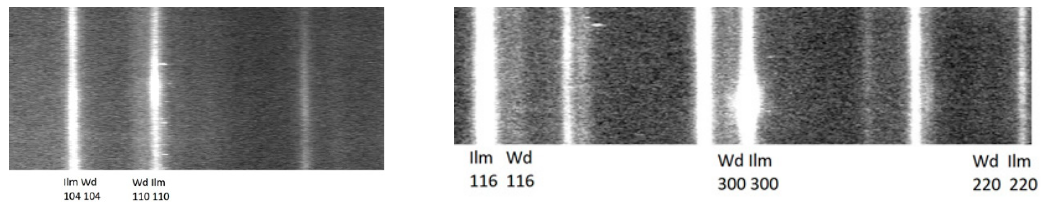
Figure 2. Diffractograms of ilmenite-wangdaodeite aggregates from Ries xenolith ZLN114c from the low angle and high angle range (left and right panel, respectively). Due to the noticeably different c/a ration, reflections of wangdaodeite occur at lower Bragg angles for the zone hk0 and at higher angles for hkl. Only fringes that are noticed as distinct already in the diffraction image are labeled. The entire set of observed Bragg reflections is shown in the integrated pattern in Figure 3 and given in Table 3. Interestingly, ilmenite exhibits some azimuthal intensity variations which indicate crystallite texture whereas diffraction of wangdaodeite does not exhibit deviations from random crystallite orientation.